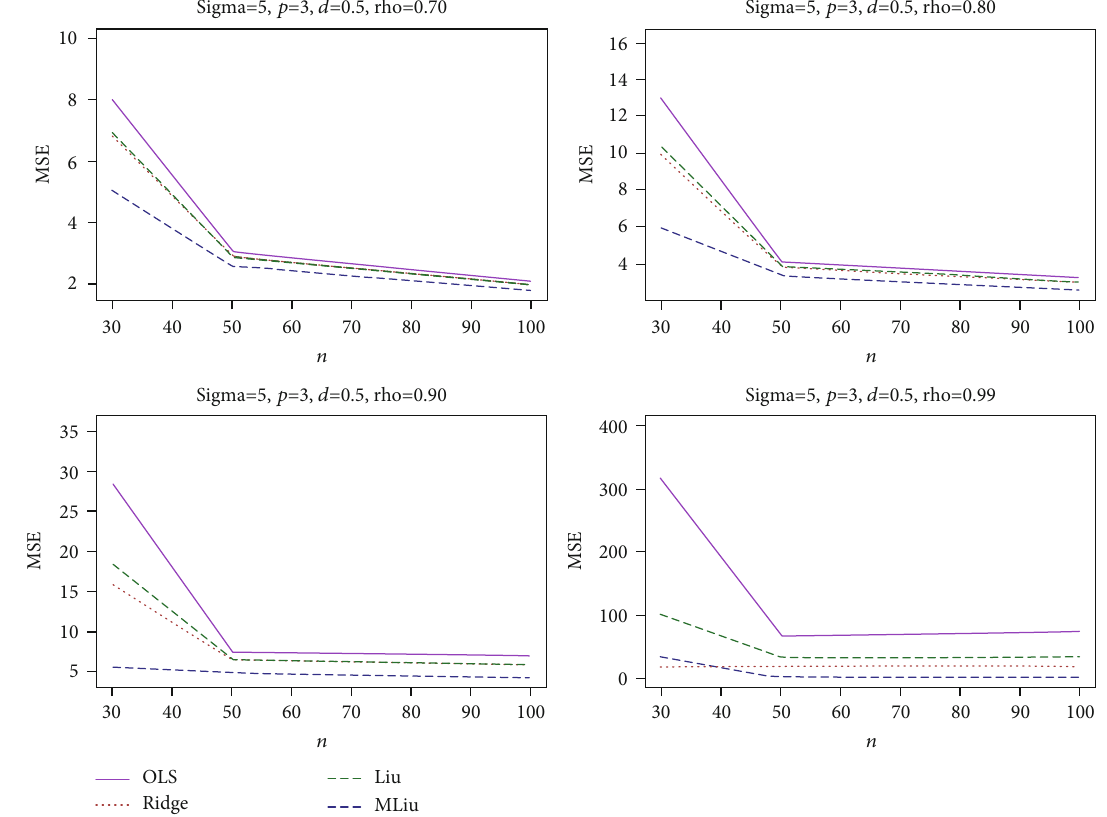
Figure 4: Estimated MSEs for n = 30 , 100; sigma = 5 ; p = 3 ; d = 0 : 5 ; and di ff erent values of ρ